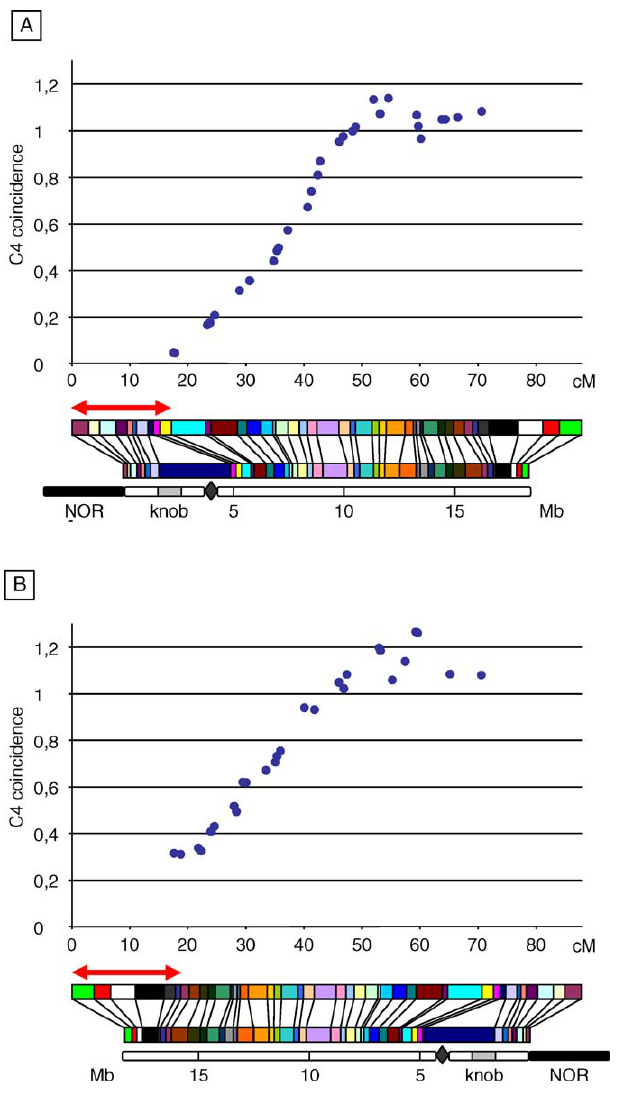
Figure 7. C4 Coincidence Plots along the Male Chromosome 4 All possible combinations between a fixed and a nonoverlapping interval (each being 17.5 cM 6 5%) were used for calculation of coefficient of coincidence, defined as the frequency of double-COs divided by the frequencies of COs in both intervals (see Materials and Methods). These C4 coincidence values were plotted against the genetic distance between the centers of the intervals. The fixed interval is located at the end of either (A) the short arm or (B) the long arm. Each plot is aligned with the corresponding genetic map, the physical map, and a schematic representation of the chromosome, which includes 5-Mb scale coordinates, centromere (diamond), heterochromatic knob (gray box), nucleolar organizer region (NOR, black box). For both plots, abscissa values indicate the genetic distance between the centers of the fixed and the ‘‘ moving ’’ intervals. The red two-headed arrow indicates the fixed interval